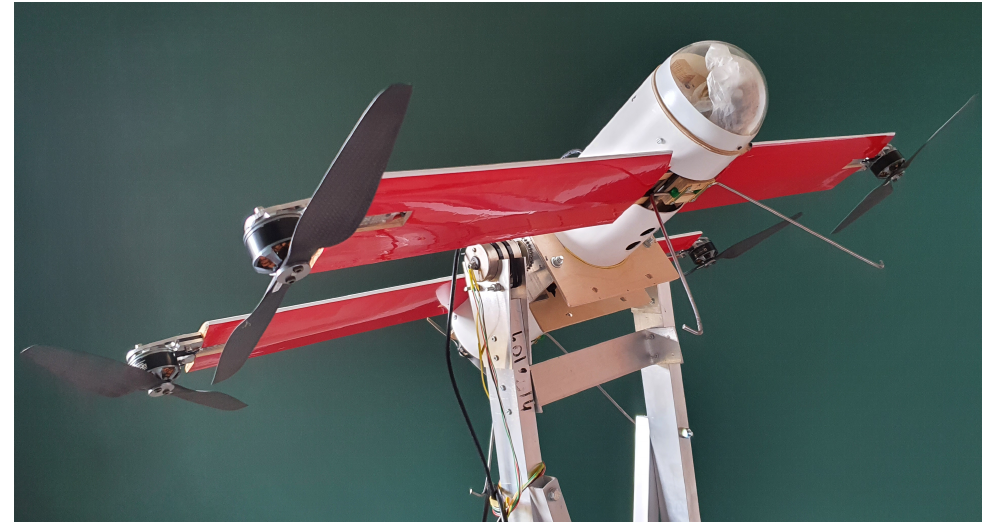
Figure 24. The drone locked in a limited-freedom test